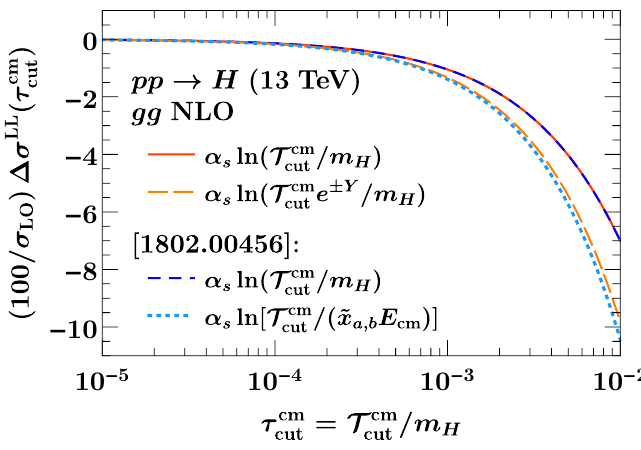
Figure 1 . Comparison of the Y -integrated LL power correction for hadronic T for gg ! Hg . The solid red and blue dashed curves show the LL results keeping only ln( T =m H ). In the long-dashed orange and dotted light blue curves we keep all ln( T e (cid:6) Y =m H ) or ln[ T = (~ x a;b E cm )] terms. In